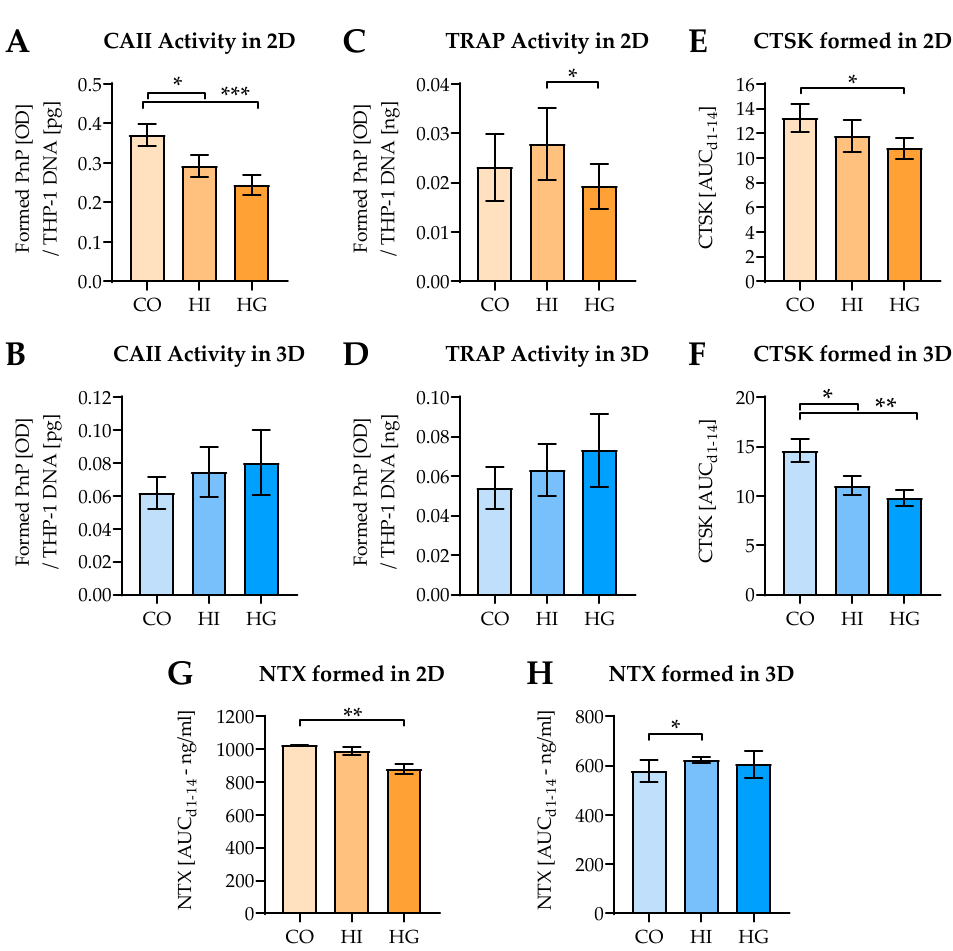
Figure 6. Influence of pre-/diabetic conditions on THP-1 cells’ function in 2D and 3D cocultures. THP-1 cells and SaOS-2 cells (2:1 ratio) were cocultured for 14 days in ( A , C , E , G ) 2D and ( B , D , F , H ) 3D, in the presence or absence of high insulin levels (HI = prediabetic conditions) or high glucose levels (HG = diabetic conditions). On days 1, 4, 7, 10, and 14 of culture ( A , B ) carbonic anhydrase II (CAII) activity and ( C , D ) tartrate-resistant acidic phosphatase (TRAP) activity were measured. At the same time points ( E , F ) cathepsin K (CTSK) and ( G , H ) collagen-type I N-telopeptide (NTX) levels were detected in the culture supernatants. CAII and TRAP activities are displayed on their day of maximal activity. CTSK and NTX levels are presented as area under the curve (AUC/mean ± SEM), to consider all measured time points. Data were compared by nonparametric Friedmann test, followed by Dunn’s multiple comparison test. * p < 0.05, ** p < 0.01, and *** p < 0.0001 as indicated. N = 3, n =